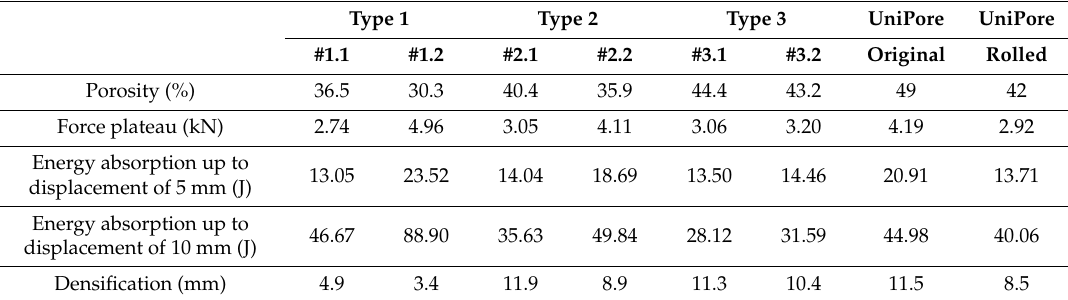
Table 2. Mechanical properties of the UniPore